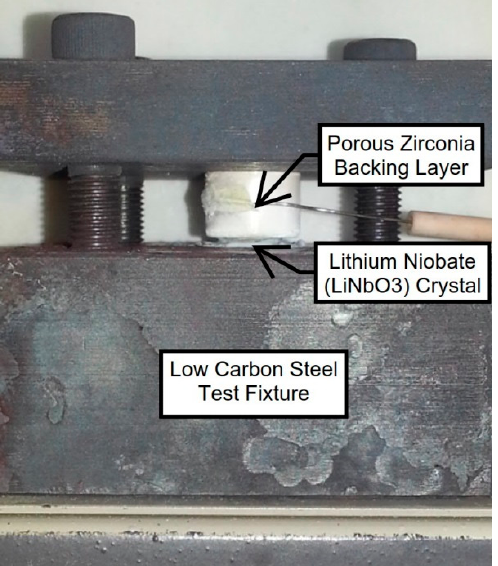
Figure 4. A transducer stack coupled directly to a low carbon steel test piece in an elevated temperature evaluation fixture. The transducer assembly is approximately 15 mm in diameter, and 10 mm tall.